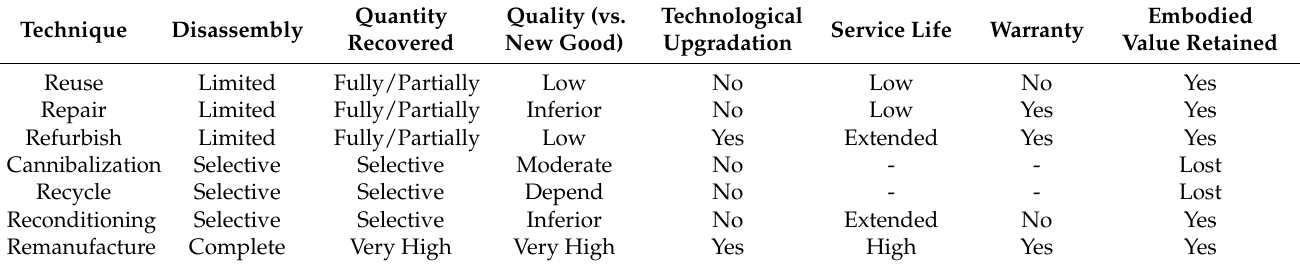
Figure 2. A figure illustrating the difference between remanufacturing, reconditioning, and repair [47]. Table 1. Product recovery techniques